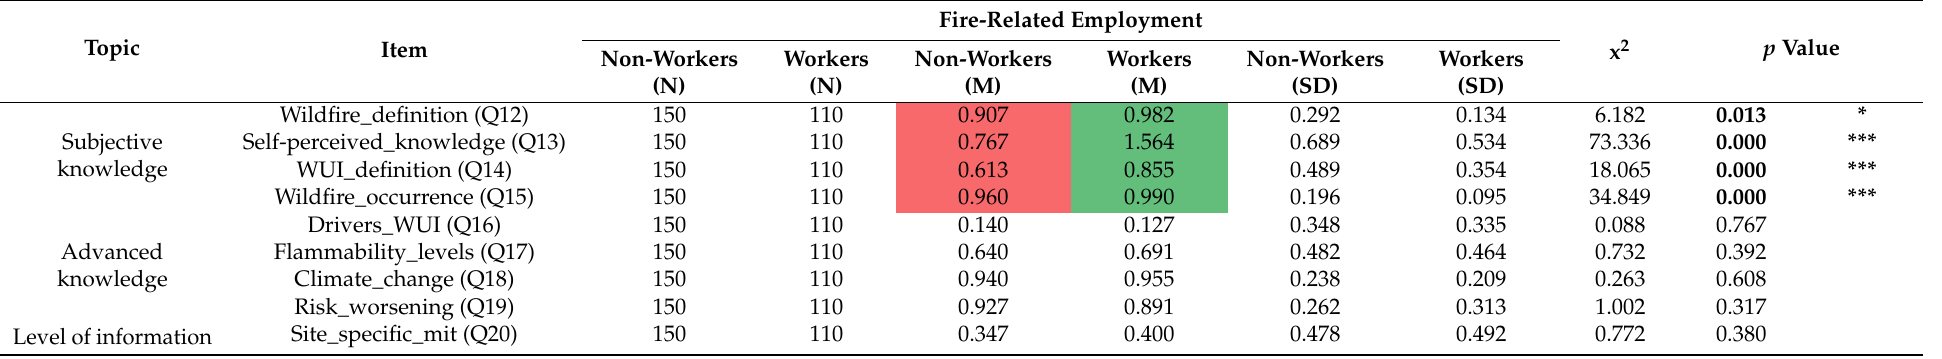
Table 3. Kruskal–Wallis test for differences in responses between the subsamples of non-fire-related and fire-related workers among participants with direct wildfire